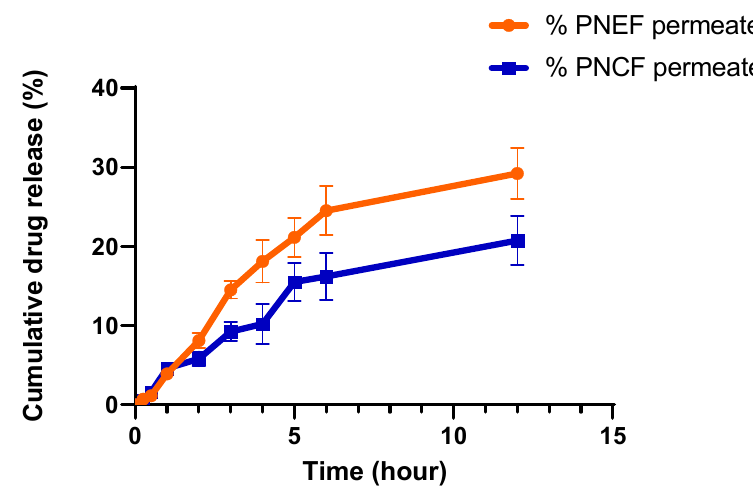
Figure 9. Comparison of % cumulative drug release from PNEF and PNCF after 12 h. Results represent mean ± standard deviation (indicated by vertical error bars), n = 3. There was a prominent difference in release rate between the PNEF and PNCF, as PNEF shows greater release in 12 h.